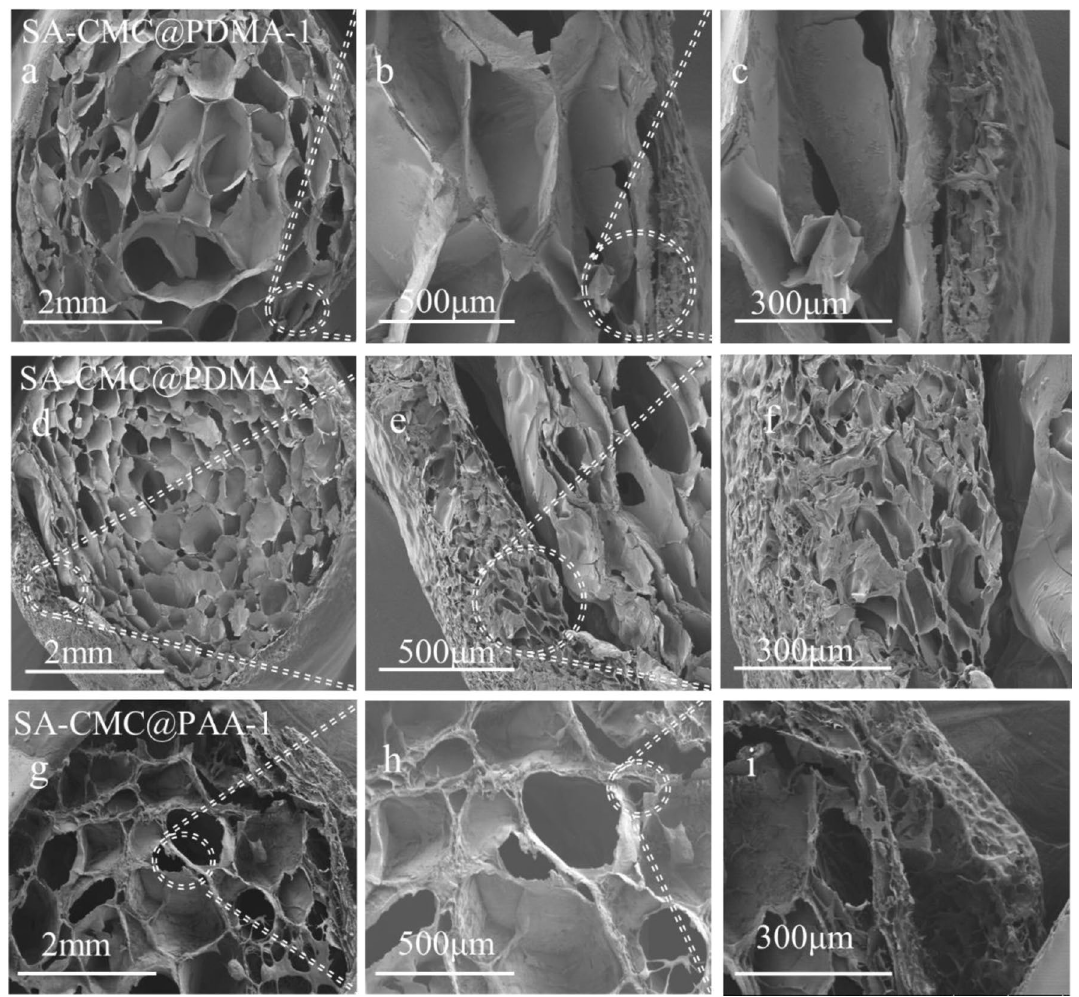
Figure 5. SEM images of double layer hydrogels with different magnification [( a – c ) SA-CMC@PDMA-1; ( d – f ) SA-CMC@PDMA-3; ( g – i )